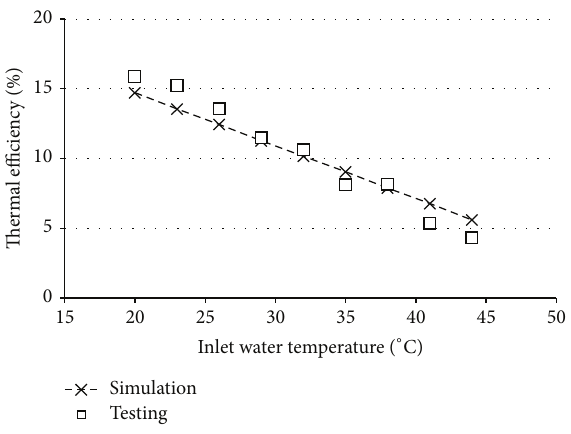
Figure 5: Variation of electrical efficiency in the daytime. )/2 , where 𝑇 𝑜 and in